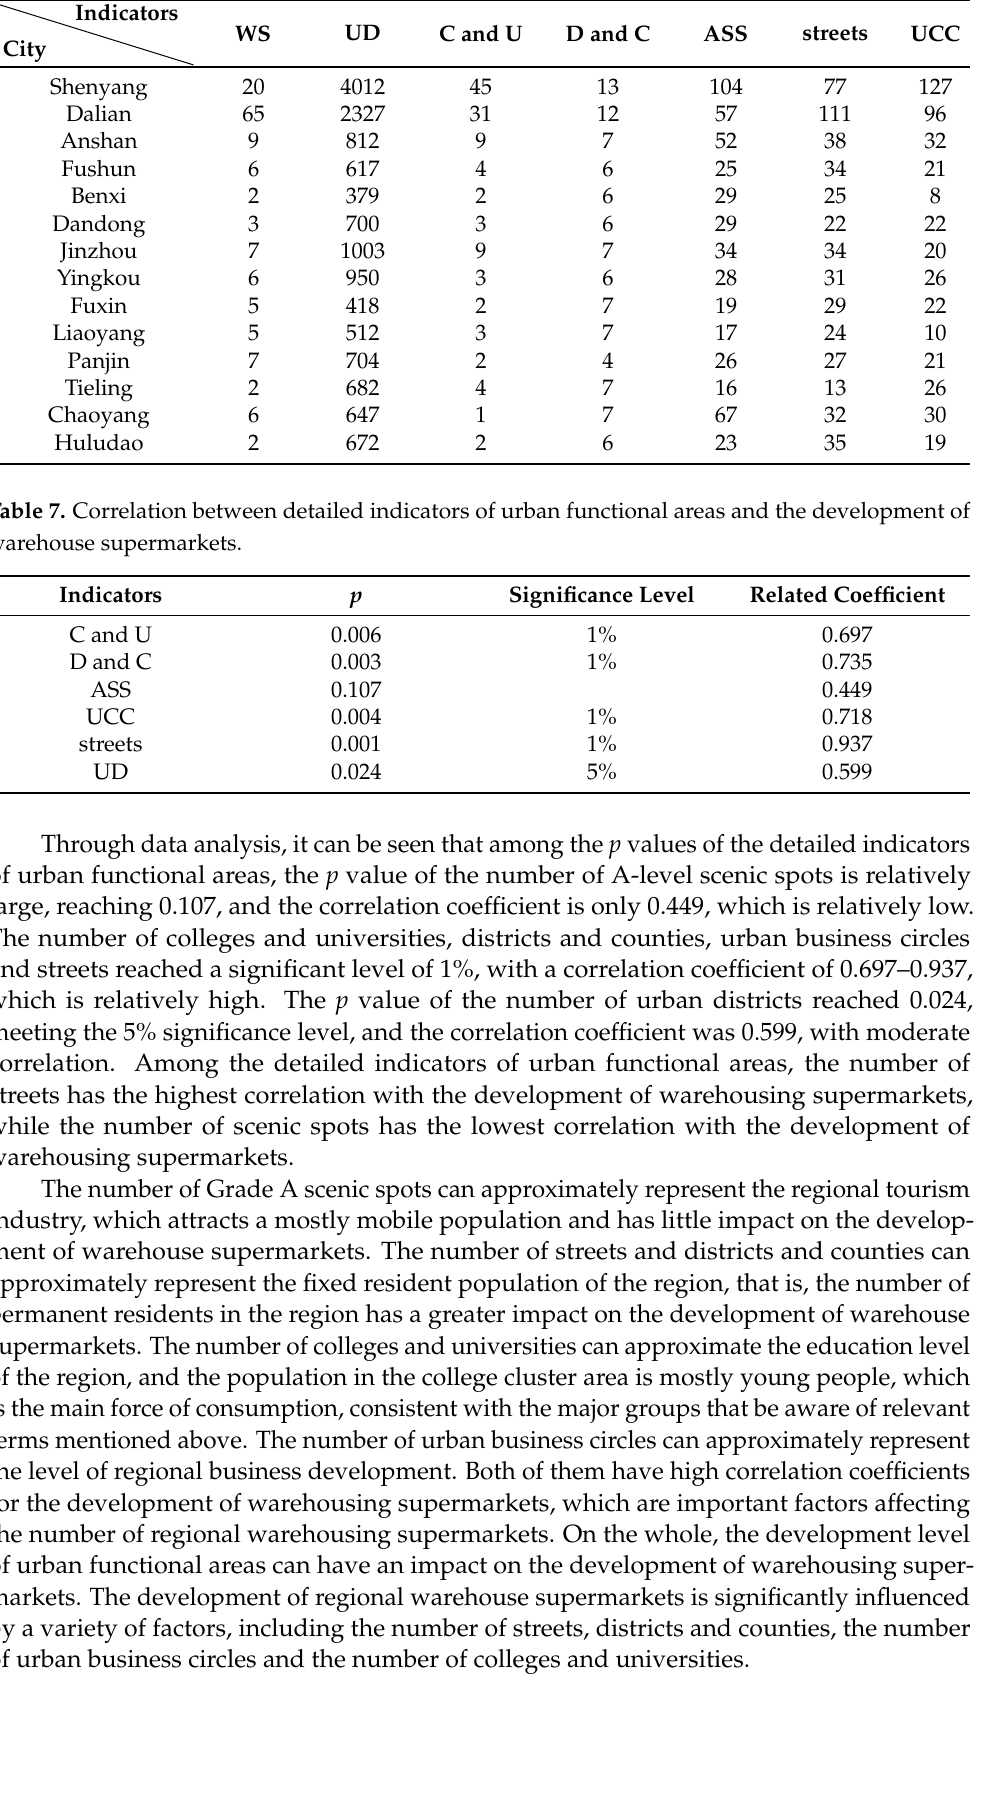
Table 6. Index Data of Urban Functional Area.